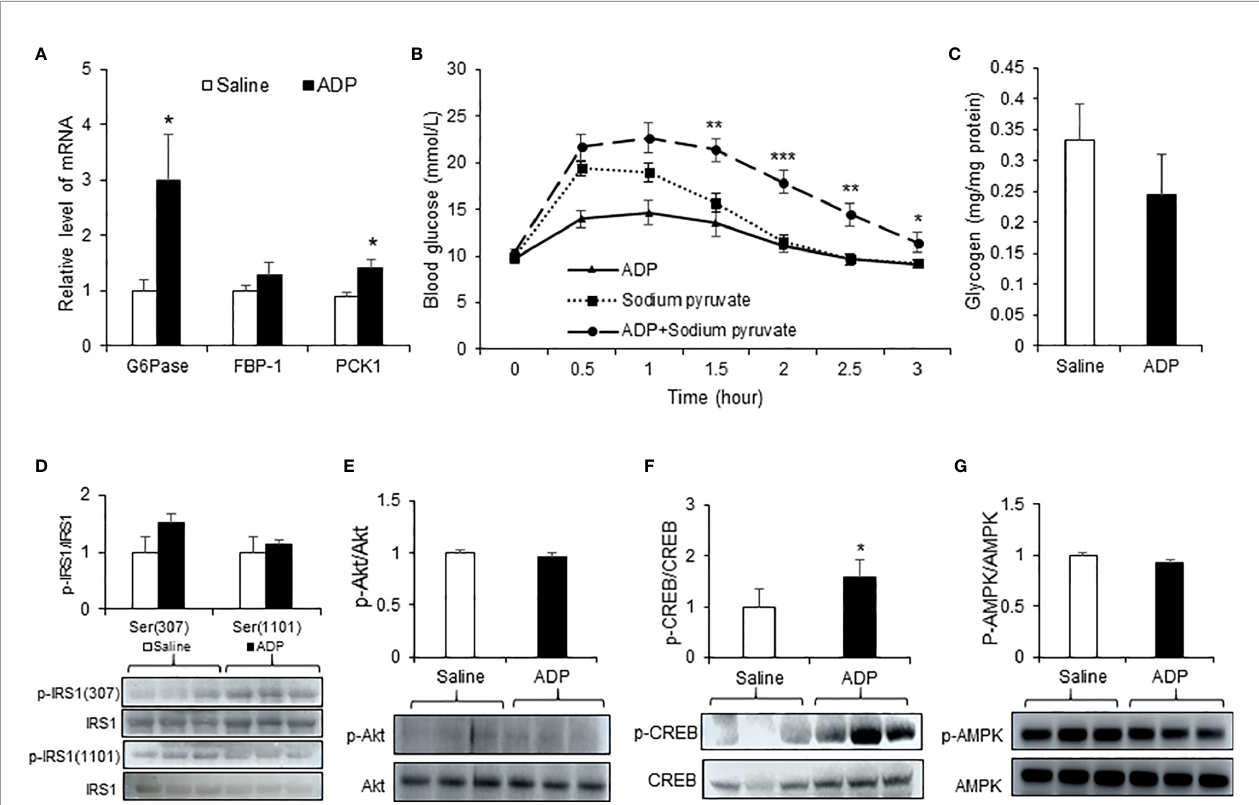
FIGURE 2 | ADP induced hepatic gluconeogenesis in mice. (A) Expression of gluconeogenic genes. The mRNA levels of gluconeogenic genes ( G6pase , Fbp1 , Pck1 ) were determined with qRT-PCR in the liver tissue of mice after injection of ADP (125 mg/kg) at 1h (n=6). (B) Pyruvate tolerance test (PTT). The mice were injected i.p. with sodium pyruvate (2 g/kg) and ADP (125 mg/kg) after 16h fasting (n=9). (C) Liver glycogen. Glycogen abundance was determined in the liver tissue of mice after ADP (125 mg/kg) injection at 1h (n=6). *p < 0.05; **p < 0.01; ***p < 0.001 vs. the sodium pyruvate group. Phosphorylation level of IRS1 (D) , Akt (E) , CREB (F) , AMPK (G) in the liver tissue at 1h after ADP injection (n=3). *p < 0.05 vs normal saline control group. The data in this fi gure represents mean ±